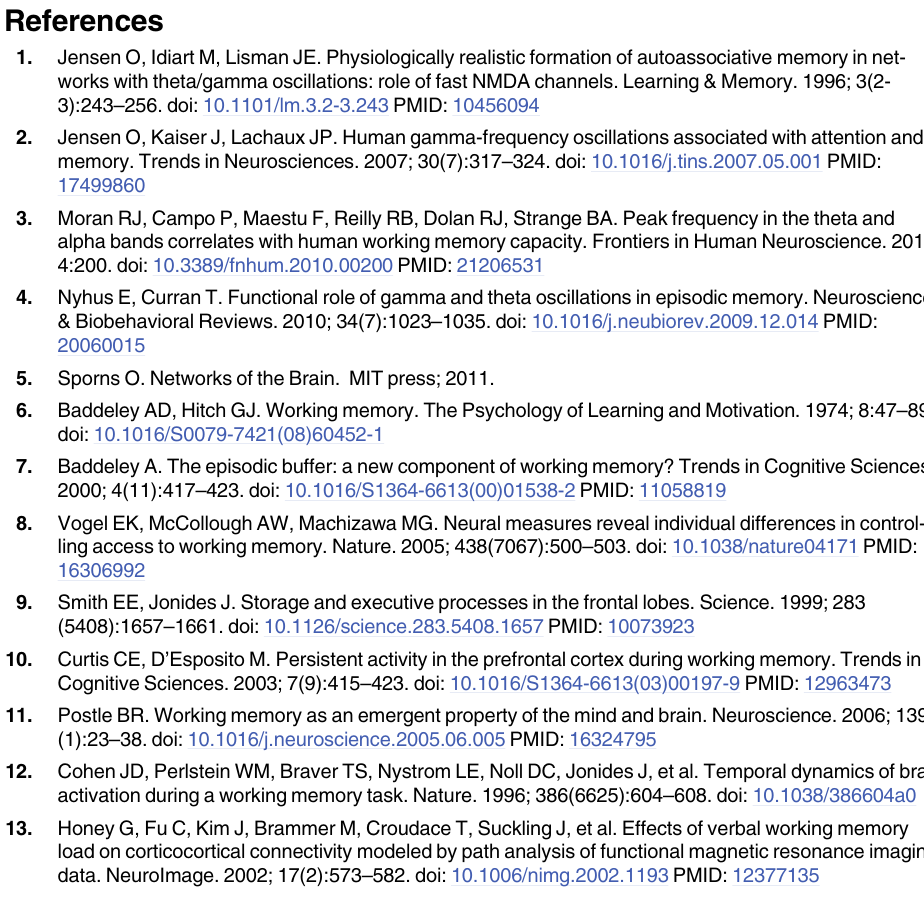
S1 Fig. The correlation analysis between metrics used in the OLS regression. Matrix ele- ments are pairwise correlation coefficients between